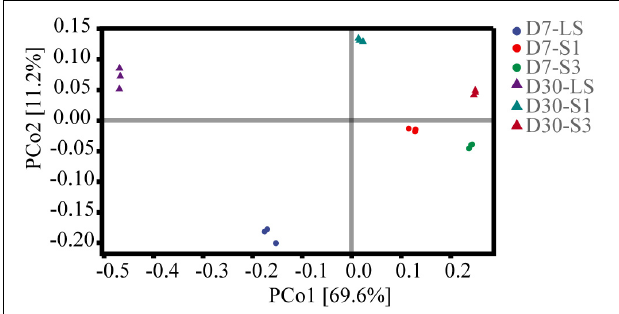
FIGURE 6 | Principal coordinates analysis (PCoA) of bacterial communities in soils from the different salinity